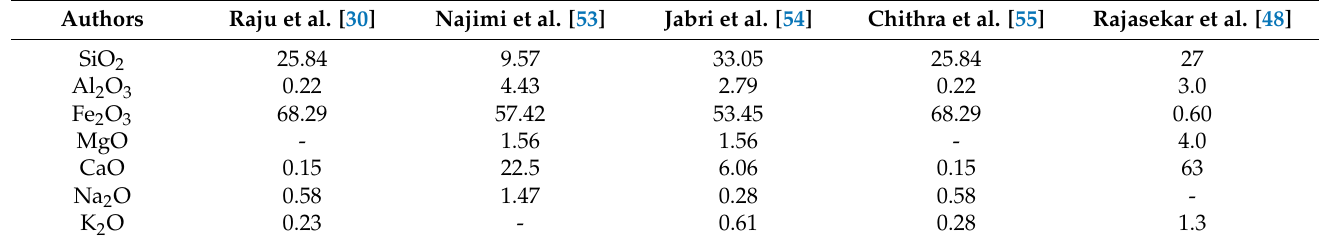
Table 2. Chemical compounds of CPS.